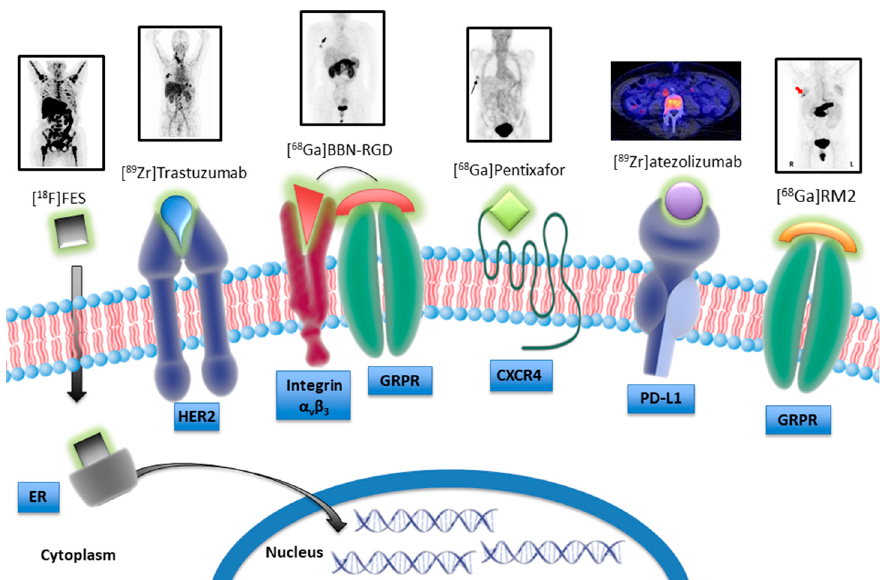
Figure 7. Schematic model illustrating nuclear tracers targeting specific receptors that are candidate for the theranostic approach.